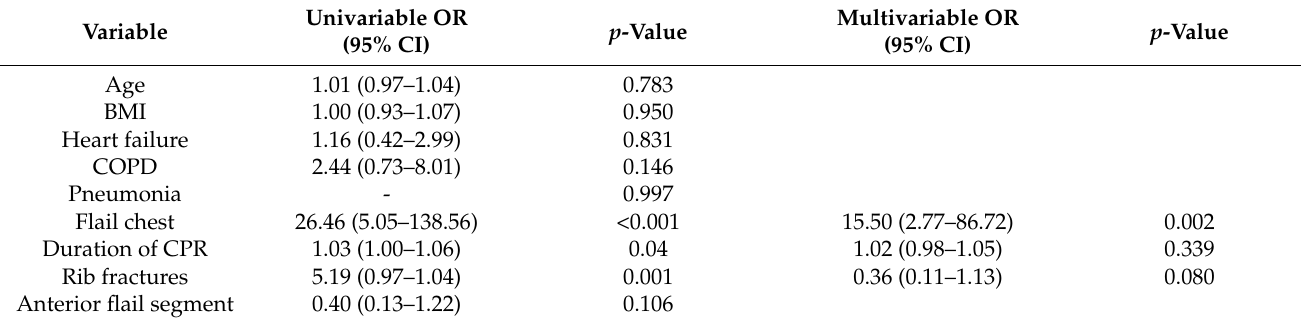
Table 4. Associations with the need for tracheostomy in logistic regression